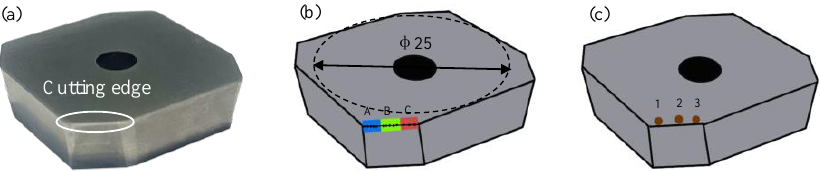
Figure 3. The cemented carbide insert: ( a ) The schematic diagram of cutting edge, ( b ) the measured position of the cutting edge radius, ( c ) the measured position of the cutting edge